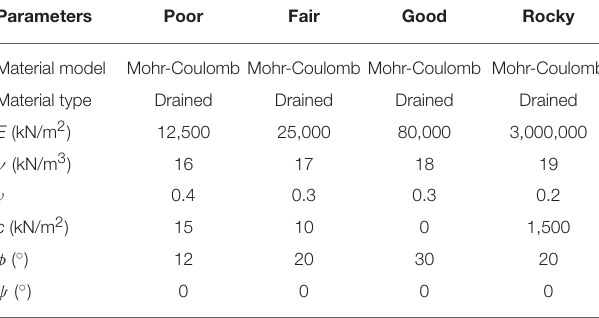
TABLE 2 | Material parameters and constitutive models for subgrades (adapted from Khordehbinan, Ballast sleeper